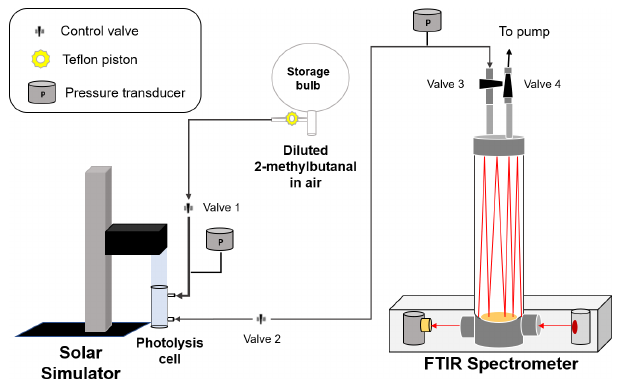
Figure 1. Schematics of the photolysis set-up using a solar simula- tor as a continuous irradiation